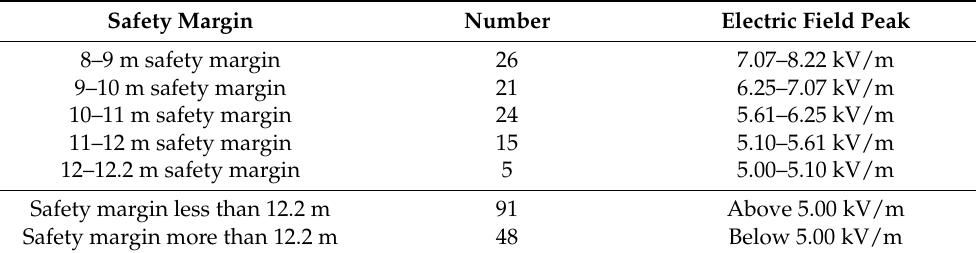
Table 5. Extension of the results to the whole power line at 60 ◦